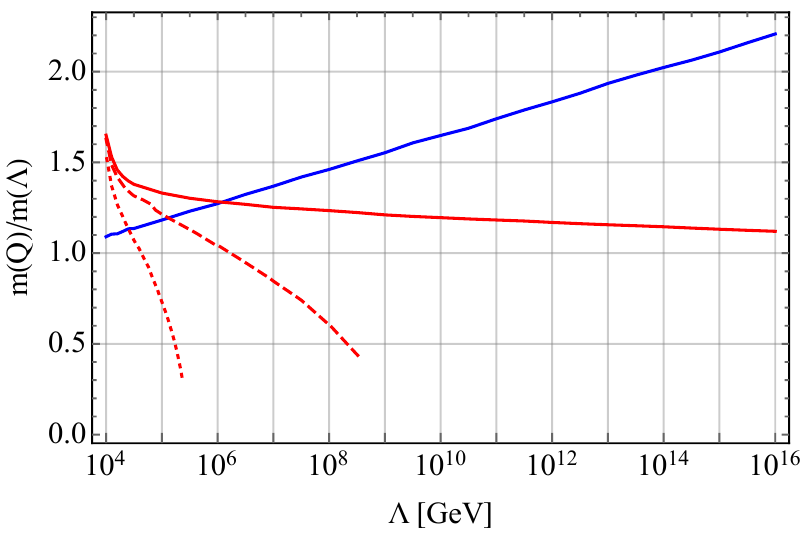
Figure 3 . Ratio of the 10% tuning bound on the IR (at Q = 1 TeV) vs. UV running mass for the gluino (blue line - this is simply A M 3 ) and the stop (red lines), for 1st and 2nd generation squarks M 3 either degenerate with the stop (solid red) or set at 5 TeV (dashed red) or 10 TeV (dotted